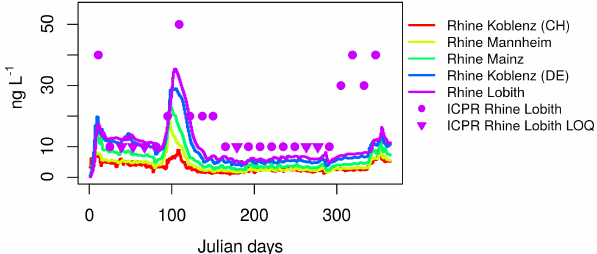
Figure 6. Comparison of predicted isoproturon concentrations along the River Rhine for 2011 compared to the observations at the measuring site at Lobith. ICPR: International Commission for the Protection of the